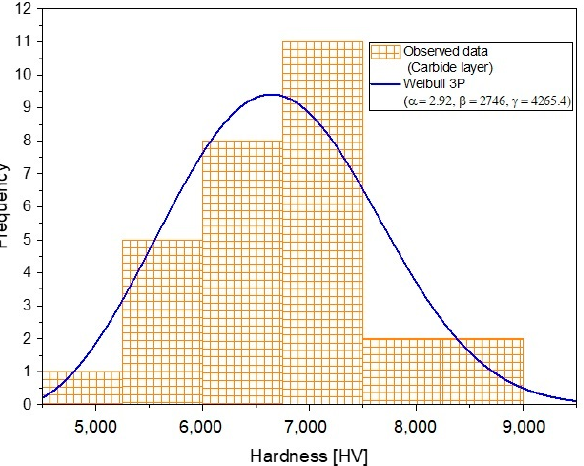
Figure 10. Carbide layer micro-hardness histogram fitted to Weibull 3P distribution. Table 9. Probability density function studied for microhardness observations in different hard lay- ers.